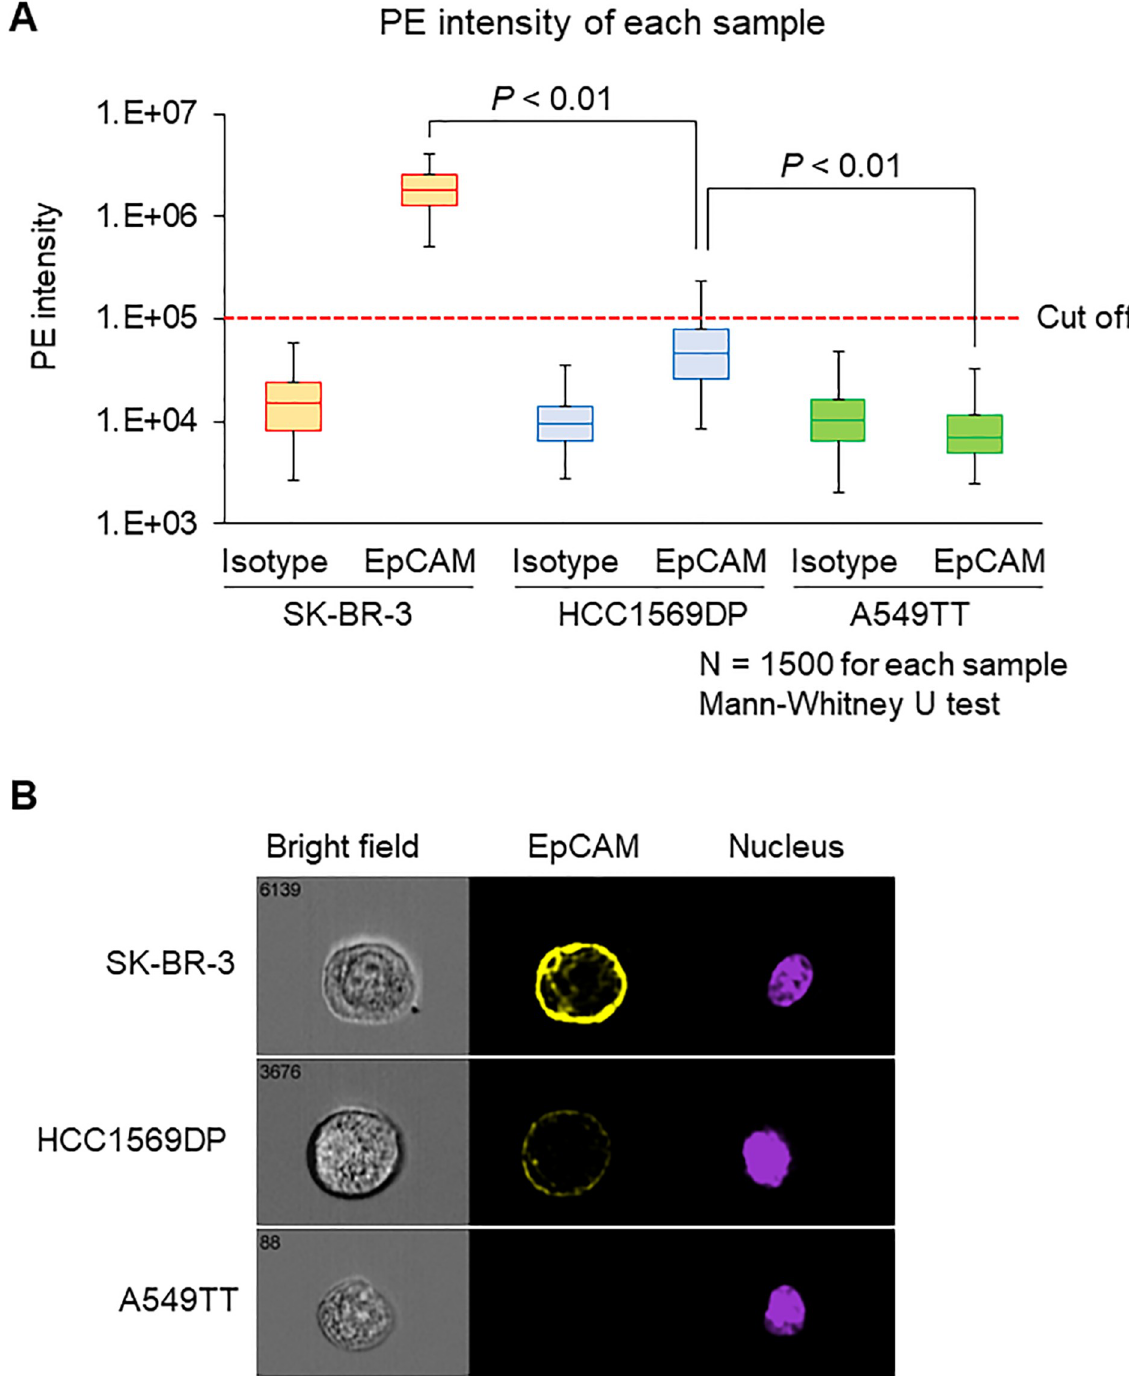
Fig 2. Evaluation of EpCAM expression level. Each cell line was stained with a PE-anti-EpCAM antibody or an isotype control antibody. Each sample contained 1500 measured cells. (A) Intensity of PE fluorescent signals. Data are presented as a box-whisker plot. The lower whisker indicates the 2.5 th percentile, and the upper whisker indicates the 99.5 th percentile. The fluorescence signal cutoff of PE was set so that the positive rate of isotype control in all three cell lines was 0%. Data were analyzed using the Mann–Whitney U-test. (B) Immunostaining images obtained by imaging flow cytometry. https://doi.org/10.6084/m9.figshare.12433157.v2.